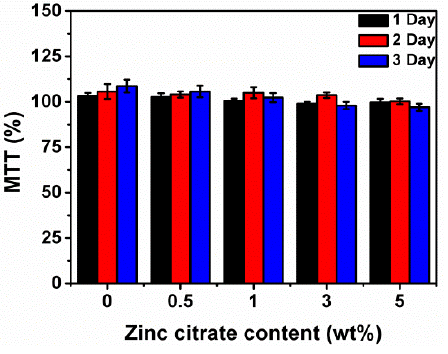
Figure 10. MTT assay result of PVA/zinc citrate nanofiber mats.